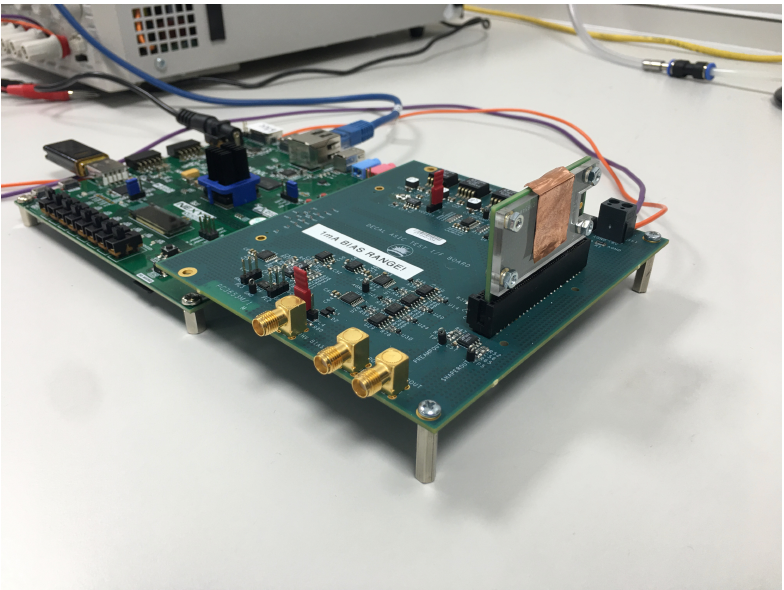
Figure 15. DECAL mounted on its daughterboard and installed in the test